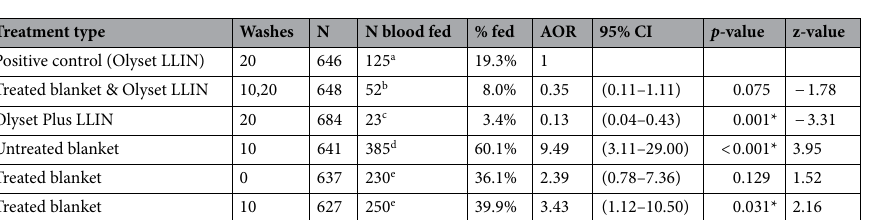
Table 2. The percentage blood feeding of Anopheles gambiae Muleba-Kisumu in the experimental huts. N is total mosquito released; AOR is adjusted odds ratio for random effects; CI is confidence interval; * Statistically significant. Values along a row bearing the same letter label are not significantly different ( p >